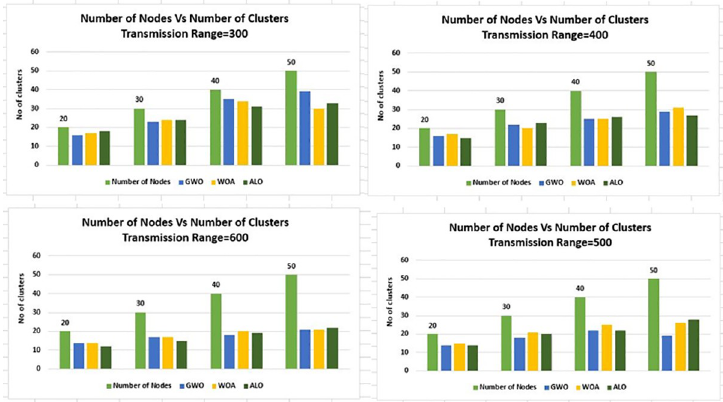
Fig 13. Node density versus number of clusters for transmission range 300m-600m & grid 4Km × 4Km.